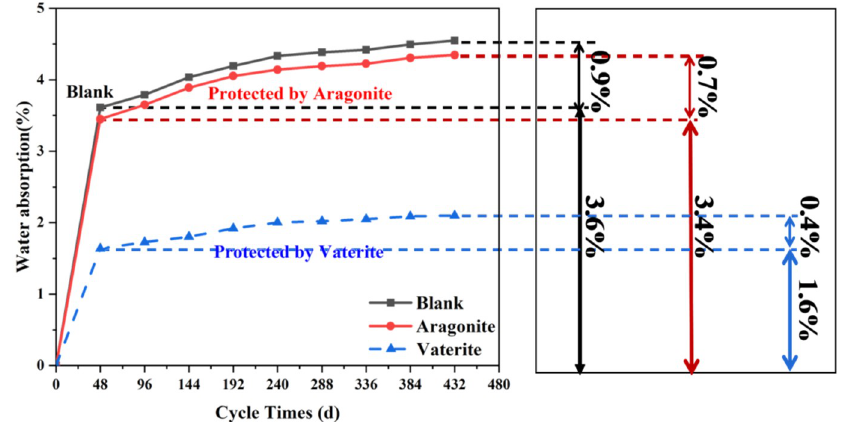
Figure 14. Water absorption curve. B is a blank stone sample, A is an aragonite-treated sample, and V is a vaterite-treated sample. V is a vaterite-treated